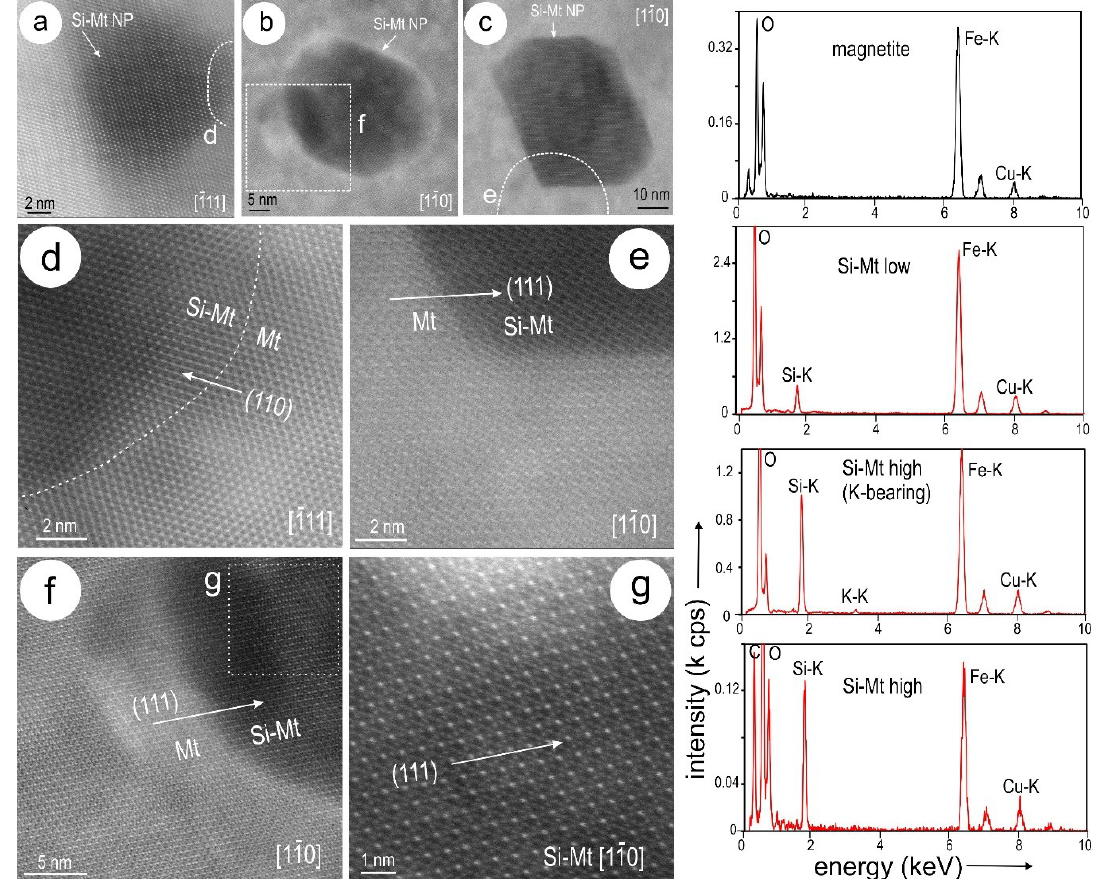
Figure 19. HAADF STEM images ( a – g ) and EDS STEM spectra (to the right) representing Si–Fe-nanoprecipitates with bleb morphology. ( a – c ) Variable morphology of bleb precipitates from smallest, rounded NPs in (a) to sub-rounded and short-prismatic in (b,c). ( d – f ) Details of boundaries between the precipitate and host magnetite (from areas as highlighted in (a)) on zone axes as marked showing epitaxial relationships between the two phases. ( g ) High-resolution image of the bleb precipitate (from area marked in f) showing the same atomic arrangement as magnetite on [110] [zone axis. Note magnetite outside the blebs is Si-free and the variation between Si/Fe ratio from low to high) in spectra to the right. The Cu signal on the spectra is from the TEM grids.